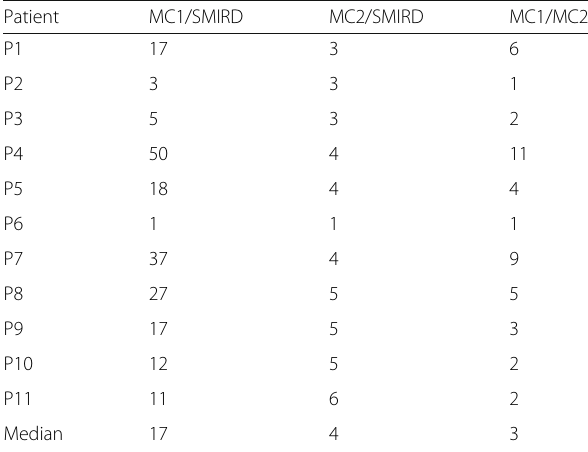
Table 3 Ratio of bone marrow absorbed dose estimates based on Monte Carlo simulations and S values Patient